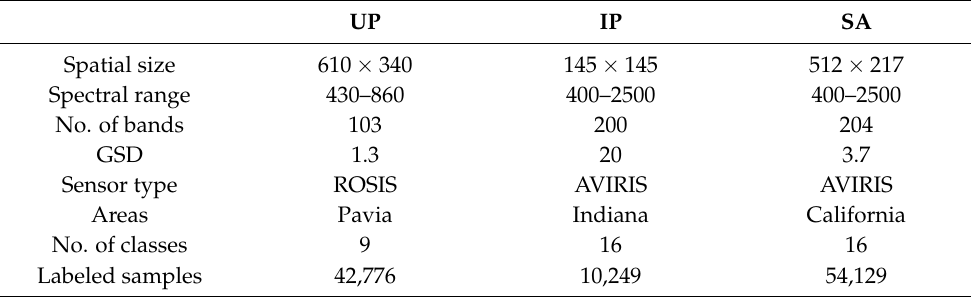
Table 2. Details of the HSI data sets. University of Pavia (UP), Indian Pines (IP), Salinas (SA),